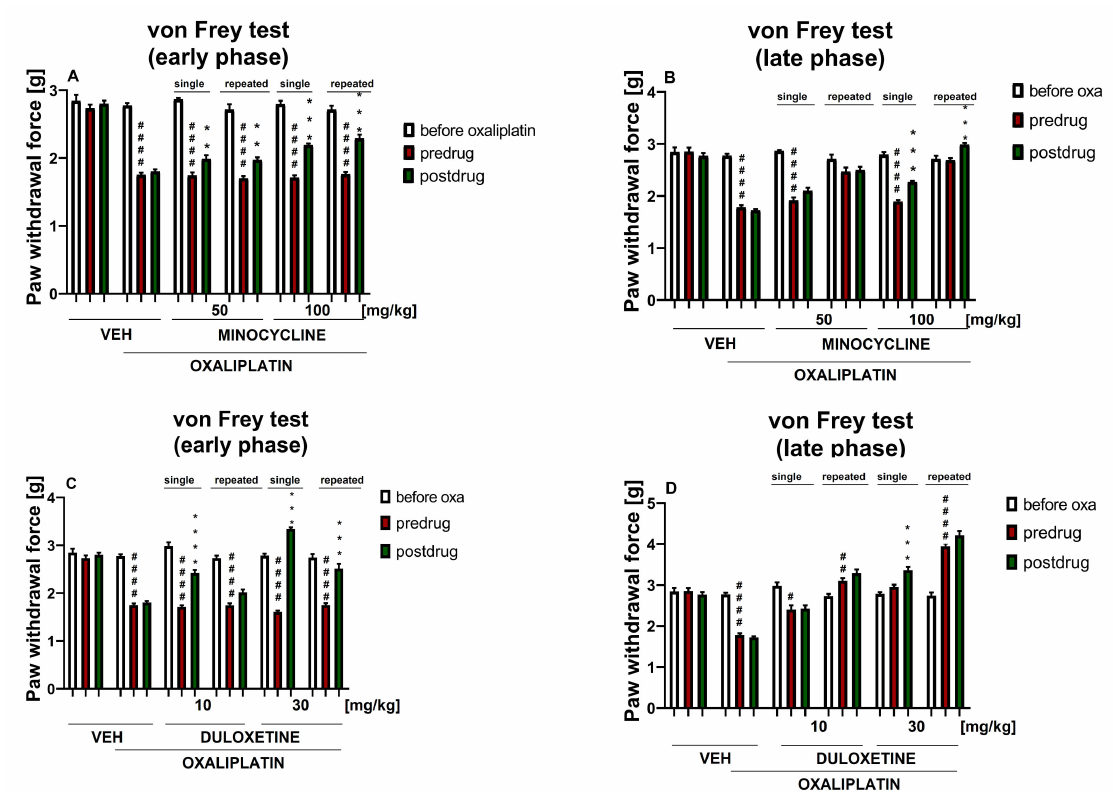
Figure 2. Effect of single-dose and repeated-dose minocycline and duloxetine, each used alone, on pain threshold in oxaliplatin-treated mice. Effect of minocycline (50, 100 mg/kg, i.p.) on tactile allodynia was measured in the mouse von Frey test on the day of oxaliplatin (oxa) administration ( A ) and 7 days later ( B ). Effect of duloxetine (10, 30 mg/kg, i.p.) on tactile allodynia was measured in the mouse von Frey test measured on the day of oxaliplatin administration ( C ) and 7 days later ( D ). The results are shown as the mean paw withdrawal threshold ± SEM for n = 9–10. Statistical analysis: repeated measures ANOVA followed by Tukey’s post-hoc comparison. Significance: # p < 0.05, ## p < 0.01, #### p < 0.0001 vs. before oxaliplatin; ** p < 0.01, *** p < 0.001, **** p < 0.0001 vs. predrug paw withdrawal threshold in the individual group. In the figure titles ‘early phase’ ( A , C ) and ‘late phase’ ( B , D ) mean two time points at which the measurements were taken (day of oxaliplatin administration and day 7 after a single-dose oxaliplatin administration, respectively). Numerical values of the paw withdrawal thresholds ± SEM presented in this figure are shown in the Supplementary Materials (Table